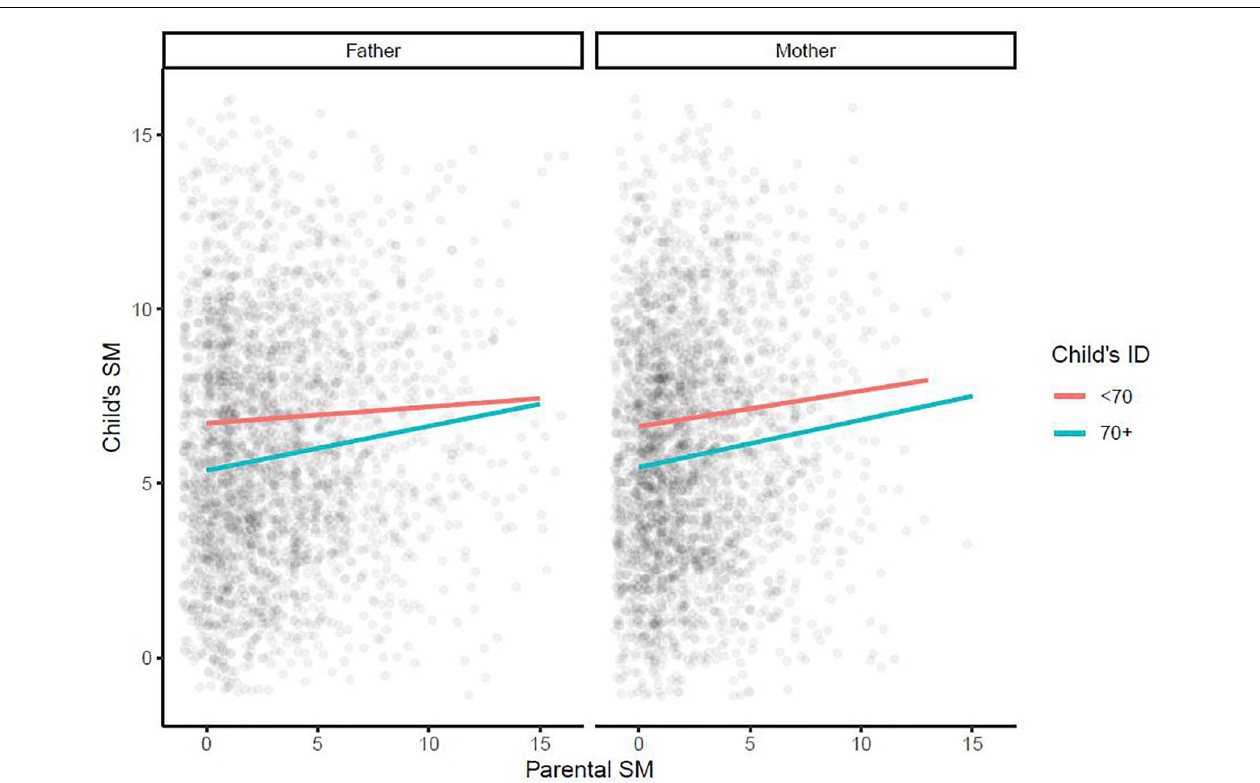
FIGURE 4 | Multiple regression model examining whether the effect of each parent’s social motivation on a child’s social motivation depends on the presence/absence of intellectual disability in children. ID, intellectual disability; SM, social